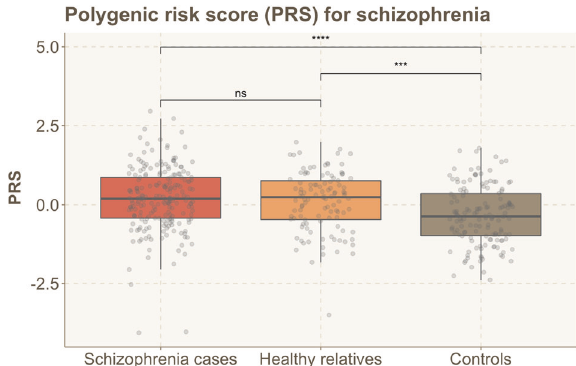
Fig. 7 Boxplots of PRS for patients with schizophrenia, healthy relatives, and controls. Pairwise comparison p -values are indicated on top. Asterisks indicate statistically signi fi cant differences: *P < 0.05, ** P ≤ 0.01, ***P ≤ 0.001, ****P ≤ 0.0001, n.s. not signi fi